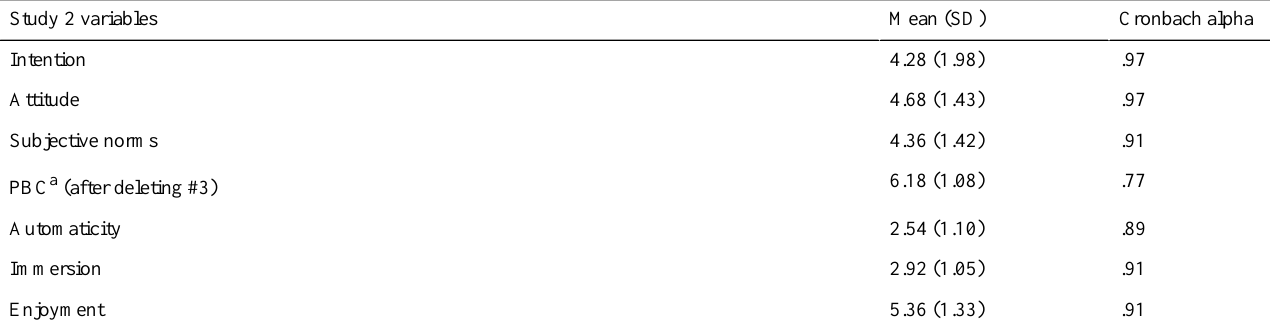
Table 2. Means, standard deviations, and Cronbach alphas for study 2 variables.